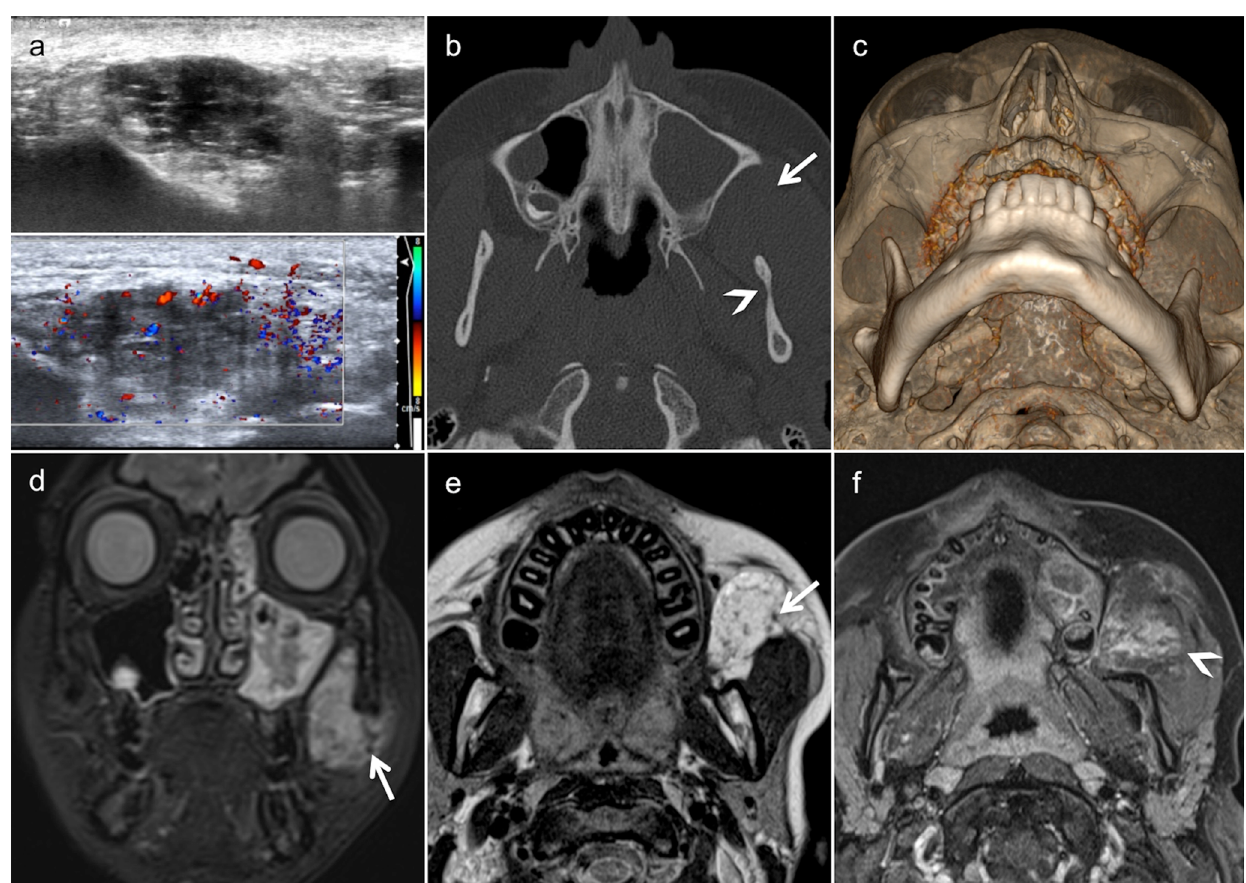
Fig. 11 Venous vascular malformation (VVM) in a 12-year-old girl complaining of increasing left cheek swelling causing major facial asym- metry and dental malocclusion. a Grey-scale ultrasound ( upper image part ) and corresponding Doppler US ( lower image part ) show hypoechoic and infiltrative mass with poor vascularisation. b Axial low-dose CT (bone window) shows shortened and remodelled left as- cending ramus of the mandible ( arrowhead ) and increased distance ( arrow ) between the left ascending ramus of the mandible and posterior